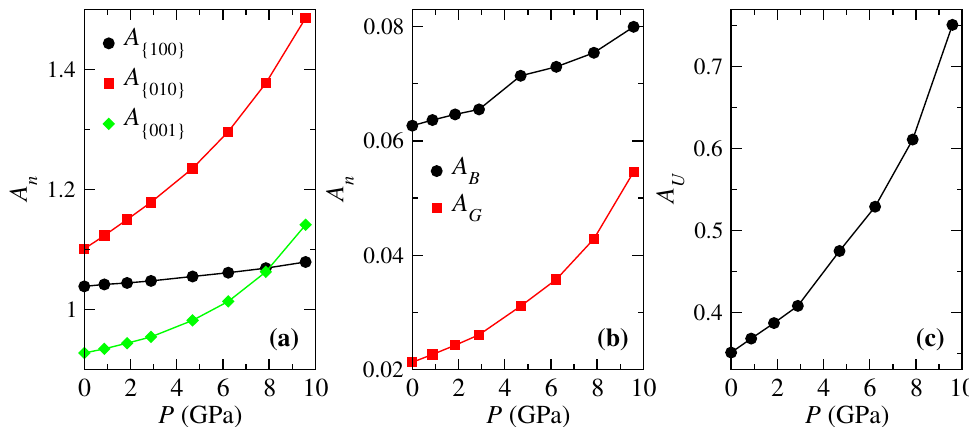
Figure 6. ( a ) Pressure dependence of anisotropy factors: ( a ) by crystallographic direction, ( b ) percent- age bulk and shear anisotropy, and ( c ) universal anisotropy for FeVO 4 - II .